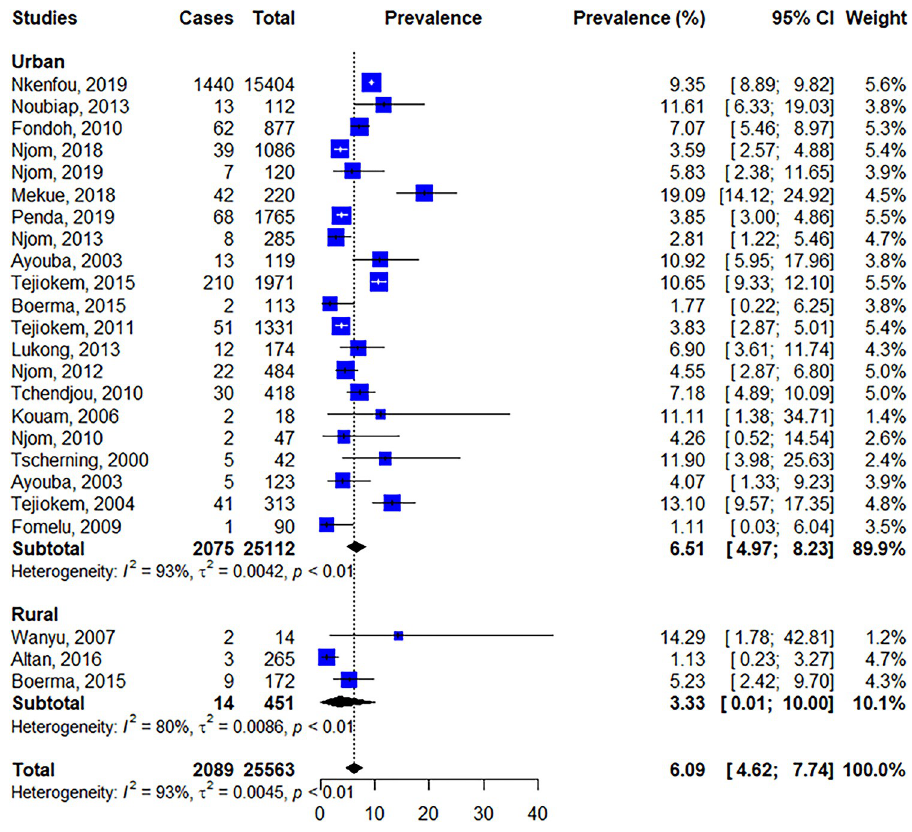
Fig 6. Forest plot of the prevalence of MTCT according to the demographic area.